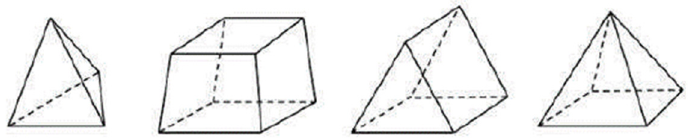
Figure 3. Grid classification.